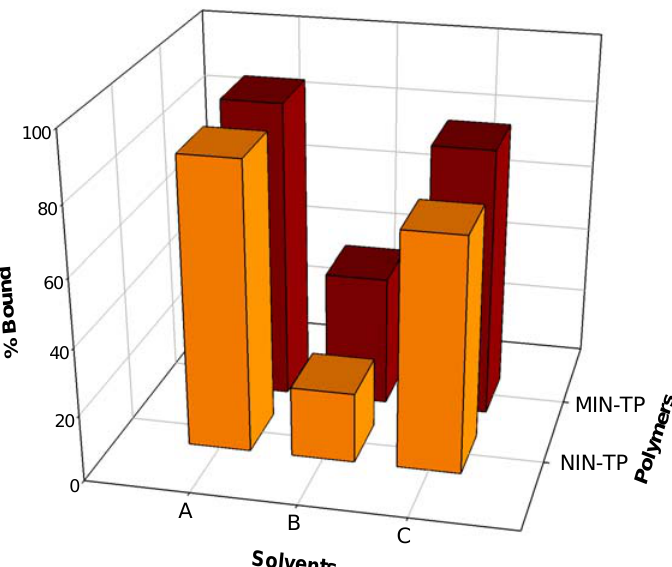
Figure 7. Rebinding of TP-imprinted and non-imprinted nanospheres with TP in various